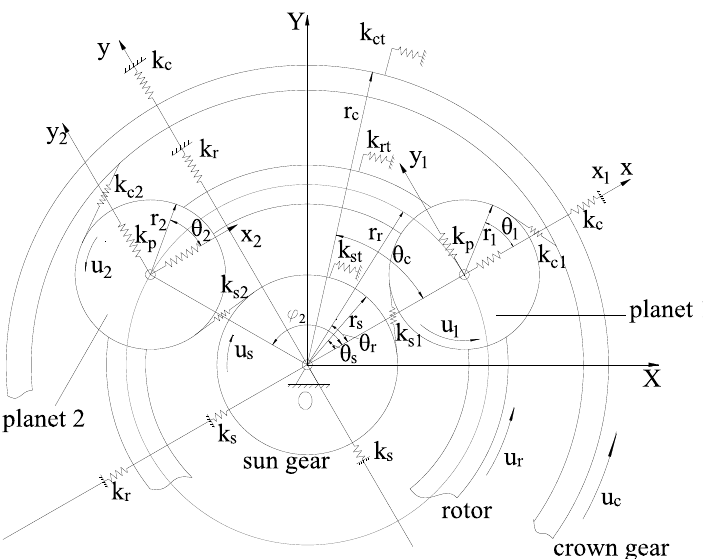
Fig. 2. The dynamic model for the magnetic planetary gear